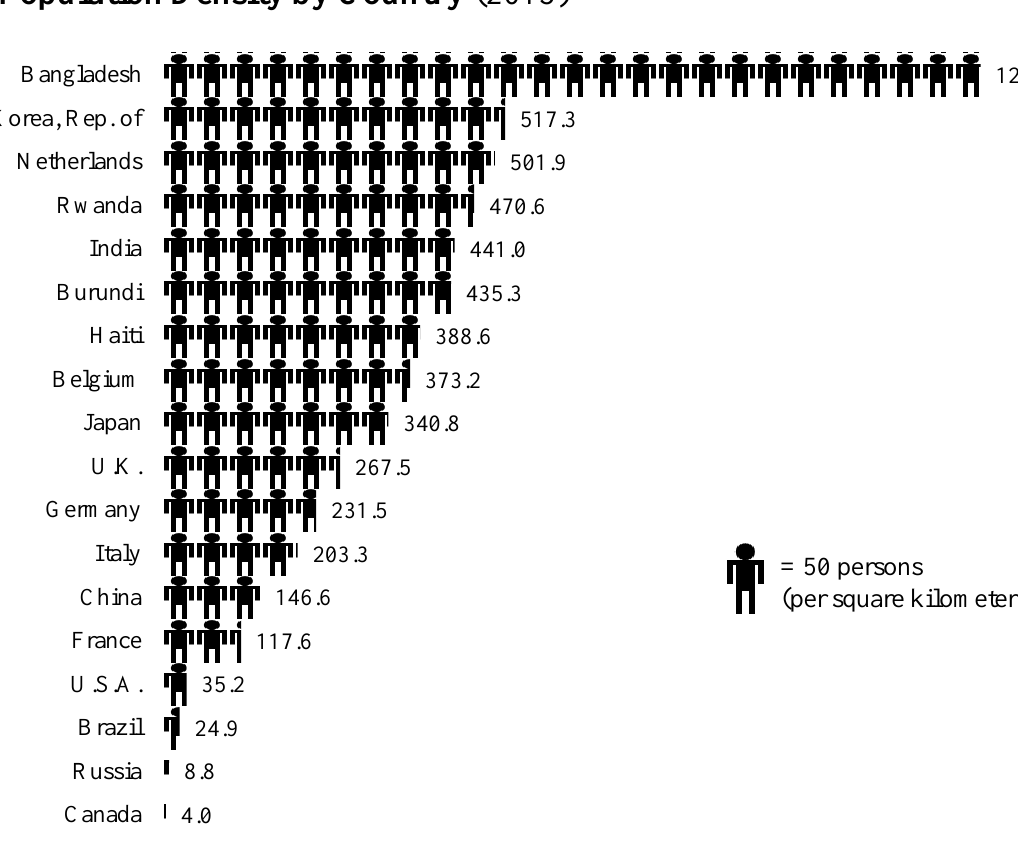
Figure 2.2 Population Density by Country